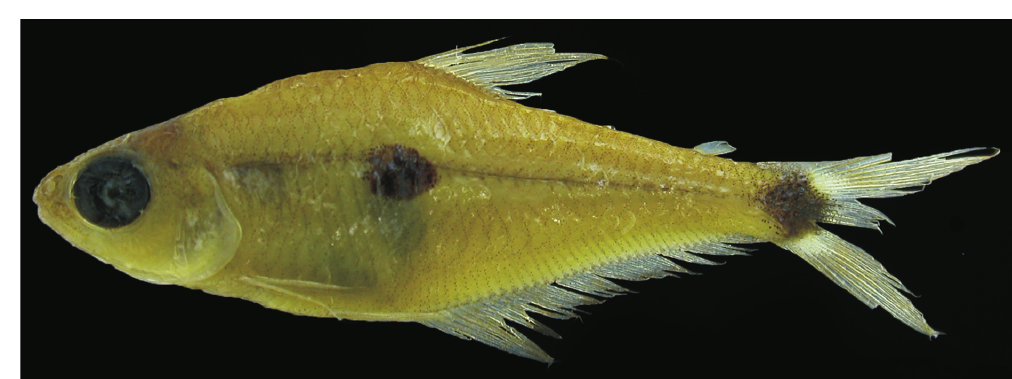
Figuar 35. Phenacogaster tegatus , MCP 17387, 26,0 mm CP, arroio Caramujo, sistema do Rio Paraguai, Mato